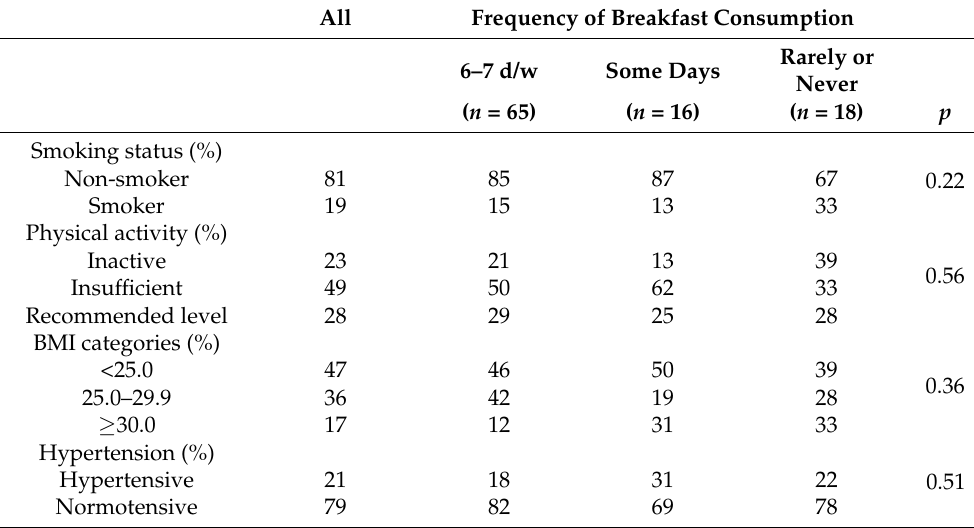
Table 2. Distribution of lifestyle characteristics and cardiovascular risk factors of the study population according to the frequency of breakfast consumption. All Frequency of Breakfast Consumption Rarely or 6–7 d/w Some Days